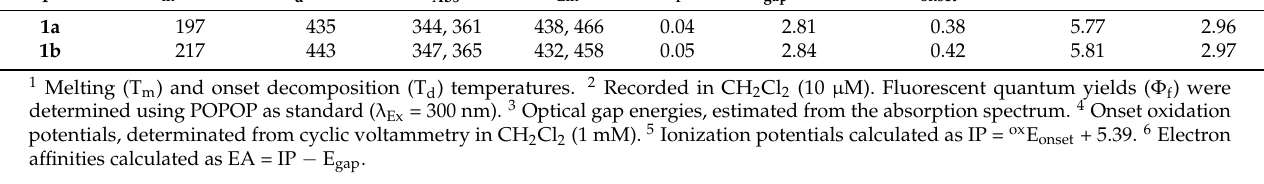
Table 3. Organic thin-film transistor (OTFT) characteristics of devices fabricated with compounds 1a – b in octadecyltrichlorosilane (OTS)- and polystyrene (PS)-treated substrates. Compound Dielectric